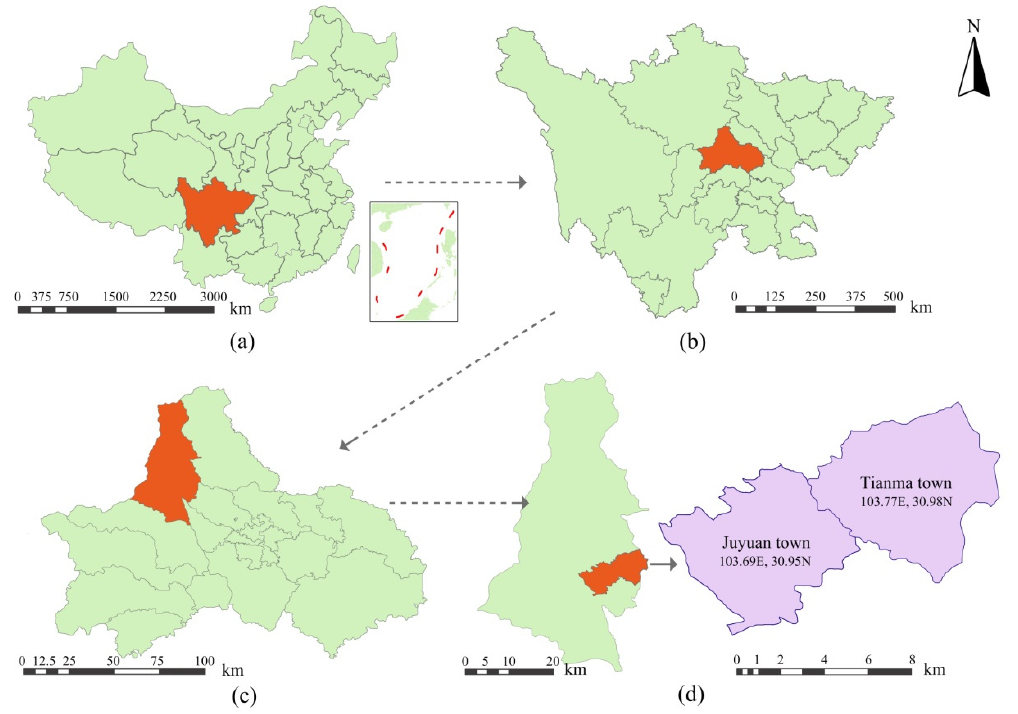
Figure 3. ( a ) Location of Sichuan Province in China. ( b ) Location of Chengdu city in Sichuan Province. ( c ) Location of Dujiangyan city in Chengdu city. ( d ) Location of Juyuan Town and Tianma Town in Dujiangyan city.